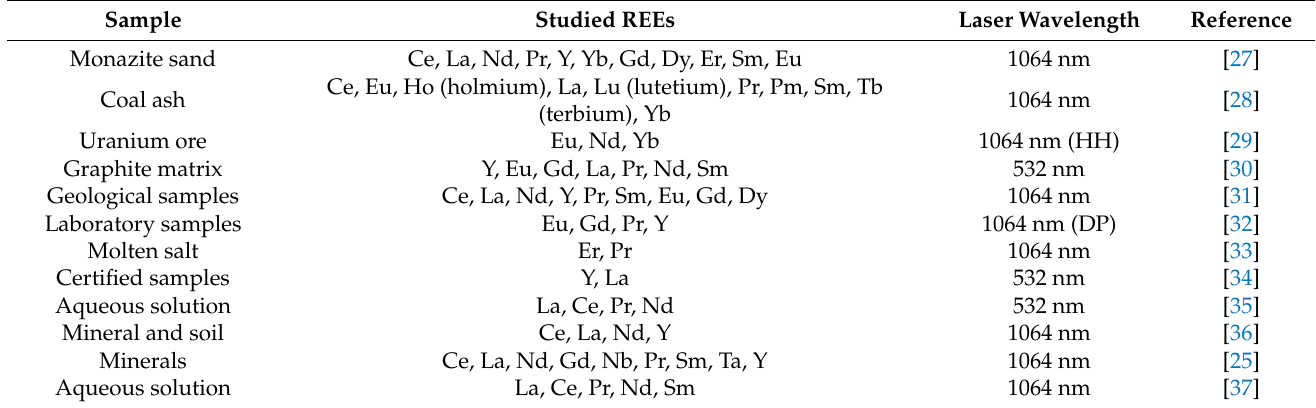
Table 1. Laser wavelengths used for REE analysis in other LIBS